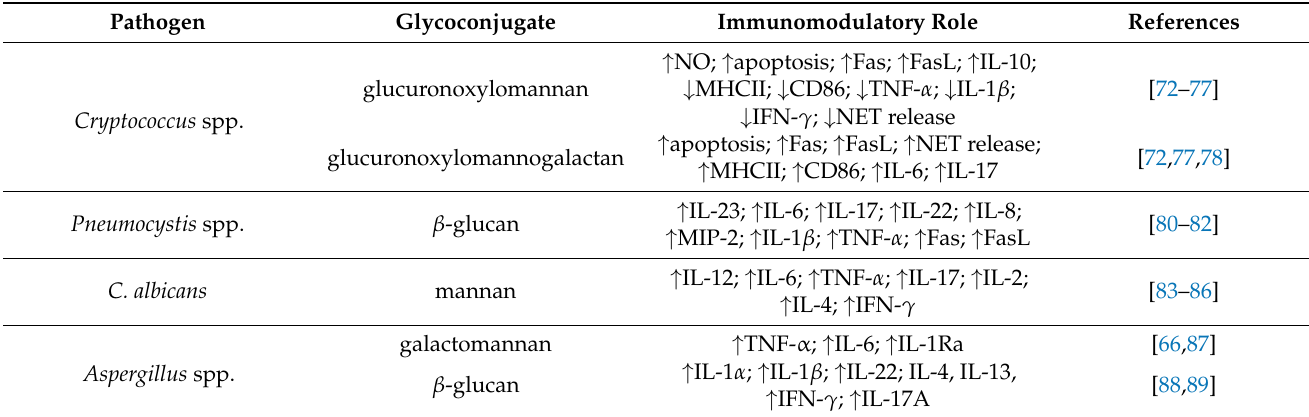
Table 1. Immunomodulatory role of some pathogenic fungi